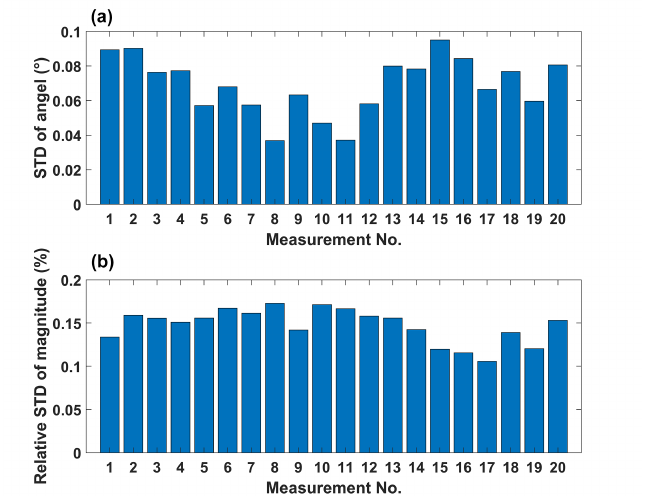
Figure 6. The standard deviation of 2000 measurements for each applied magnetic field. ( a ) Deviations of the orientation measurement. ( b ) Deviations of the magnitude